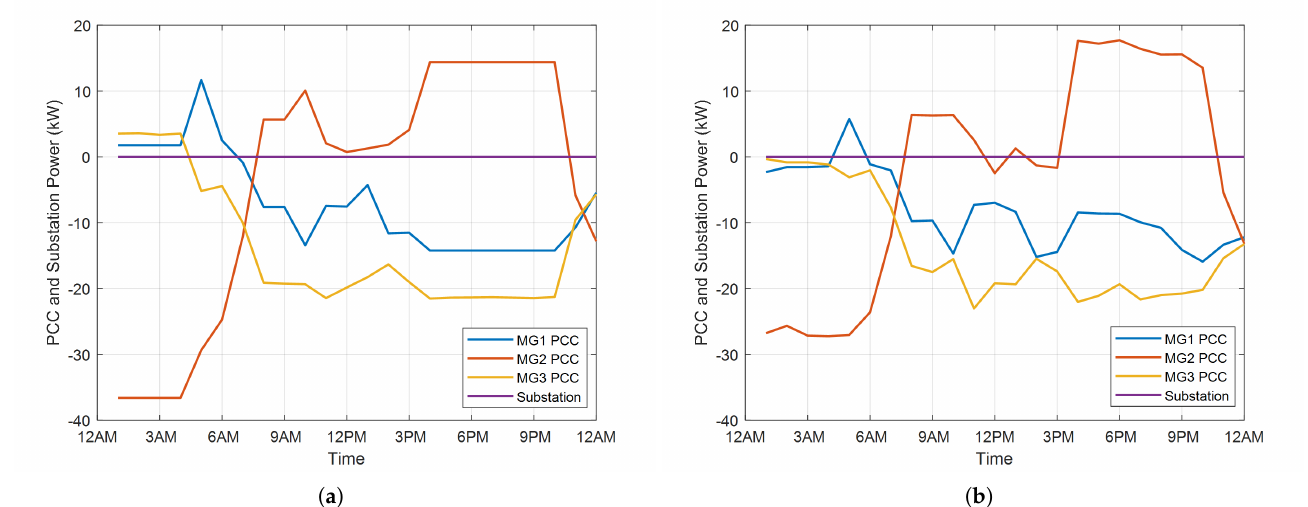
Figure 8. PCC and substation power in islanded mode. ( a ) Centralized Method. ( b ) Distributed Method.